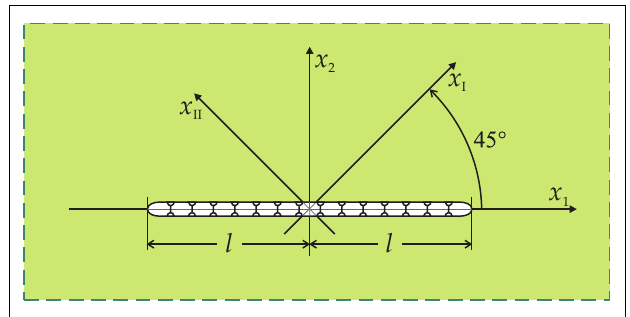
FIGURE 15 |A perturbative approach to shear band growth: a pre-existing shear band, modeled as a planar slip surface, acts at a certain stage of uniform deformation of an infinite body obeying the J 2 -deformation theory of plasticity